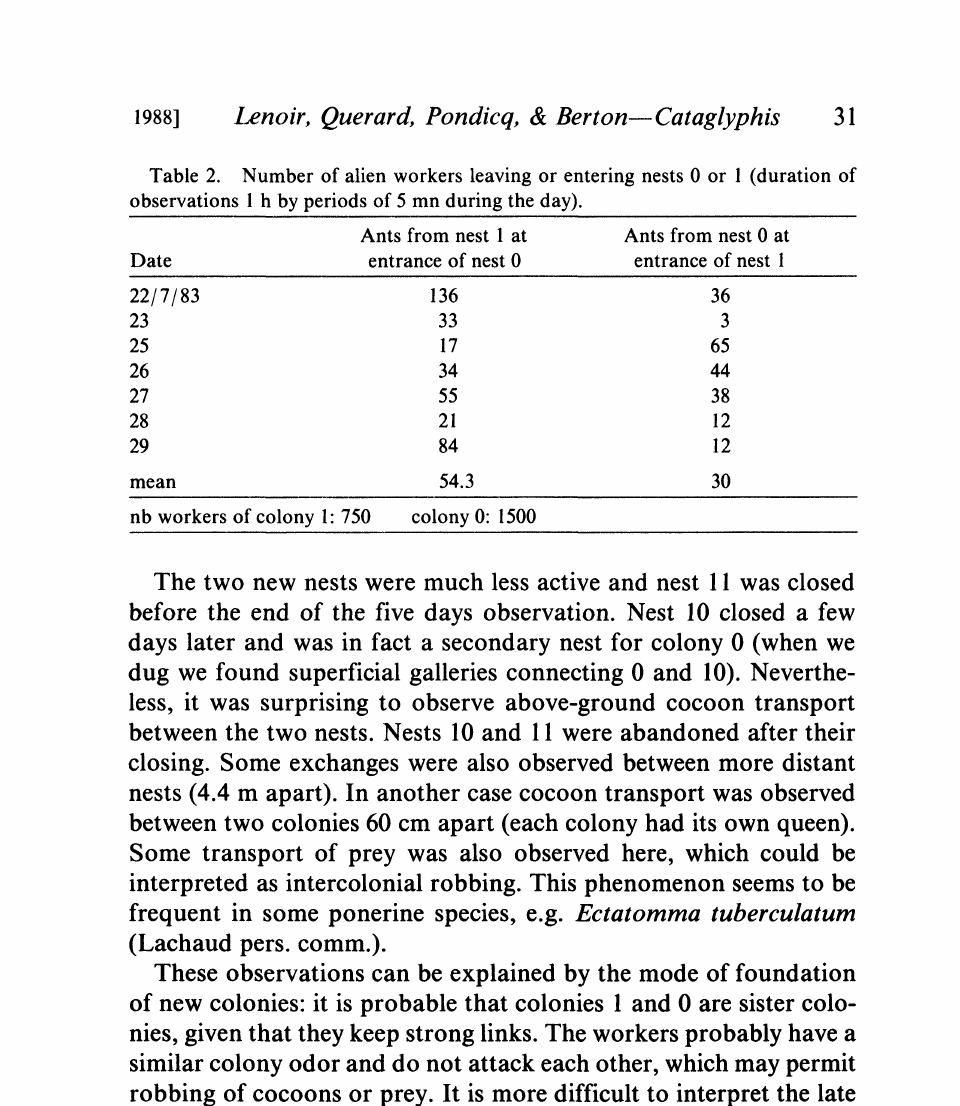
Table 2. Number of alien workers leaving or entering nests 0 or (duration of observations h by periods of 5 mn during the